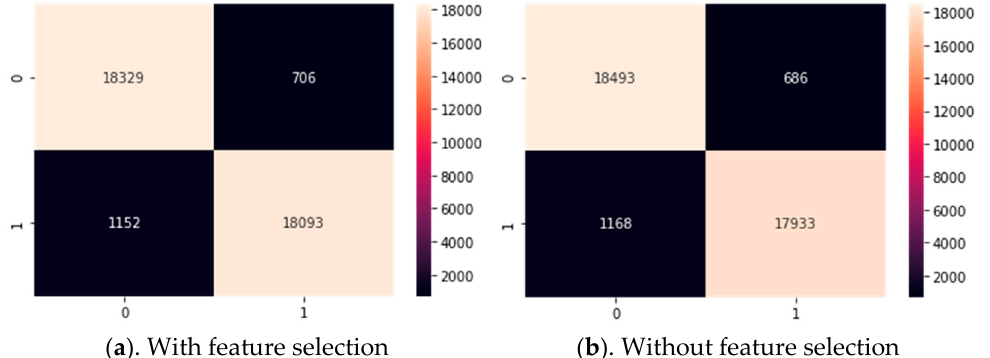
Figure 10. Confusion matrix of random forest algorithm.